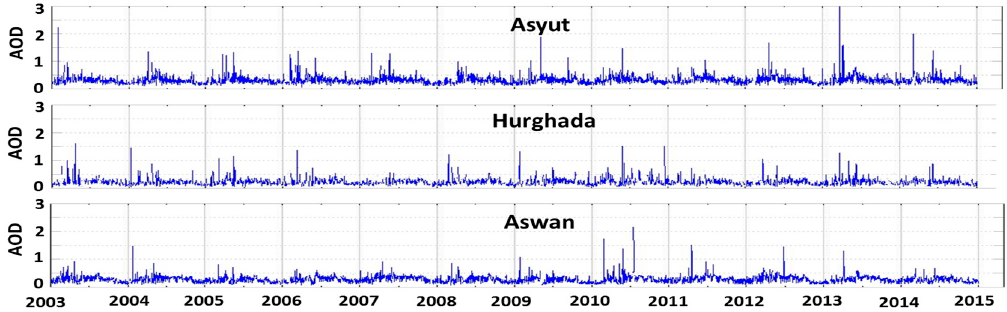
Figure 8. Daily time series of AOD from year 2003 to 2014, averaged over 50 × 50 km 2 centered at the cities of Asyut, Hurghada, and Aswan.